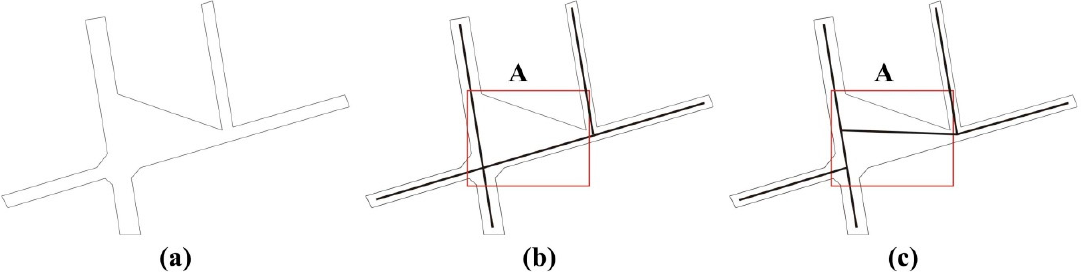
Figure 4. Retaining the structural features of the branch junctions: ( a ) branch junctions, ( b ) skeleton lines extracted with Haunert and Sester (2008) and ( c ) medial axis of the branch junctions.